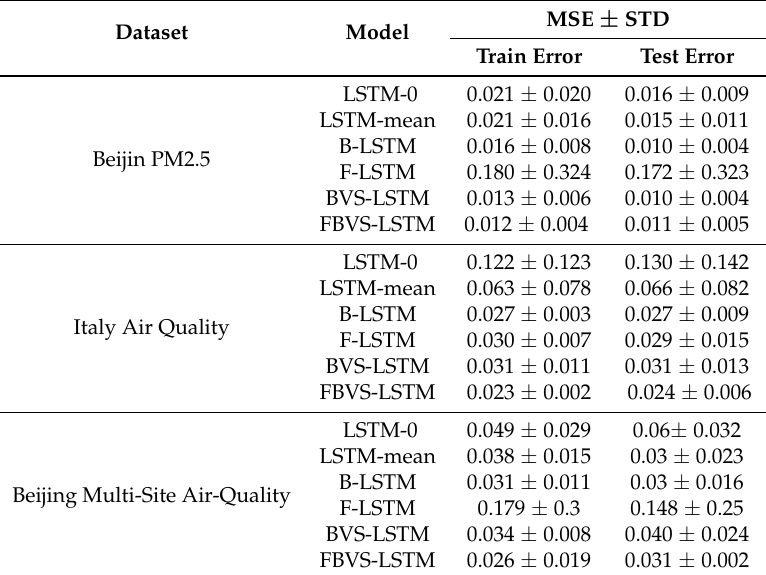
Table 3. All models performance in each